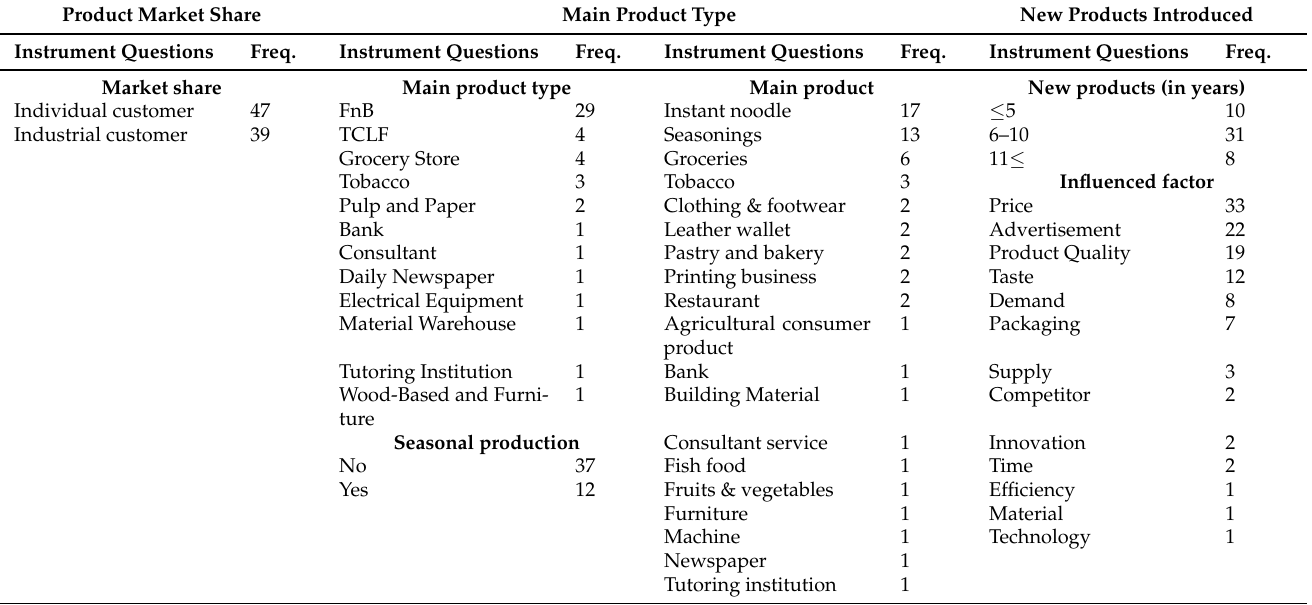
Table 3. Data collected from correspondents based on product characteristics in the product variety domain. Product Market Share Main Product Type New Products